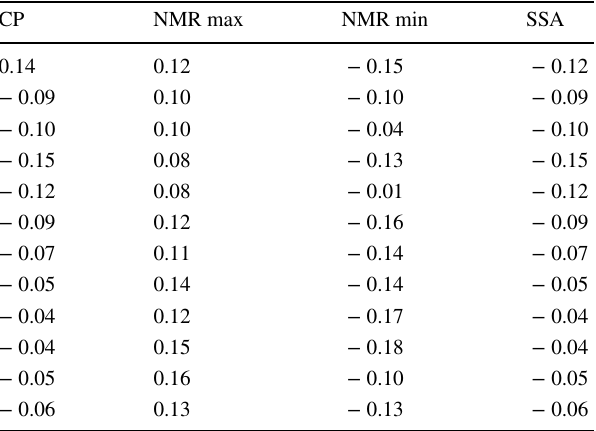
Table 3 Fractional deviations from calculated values